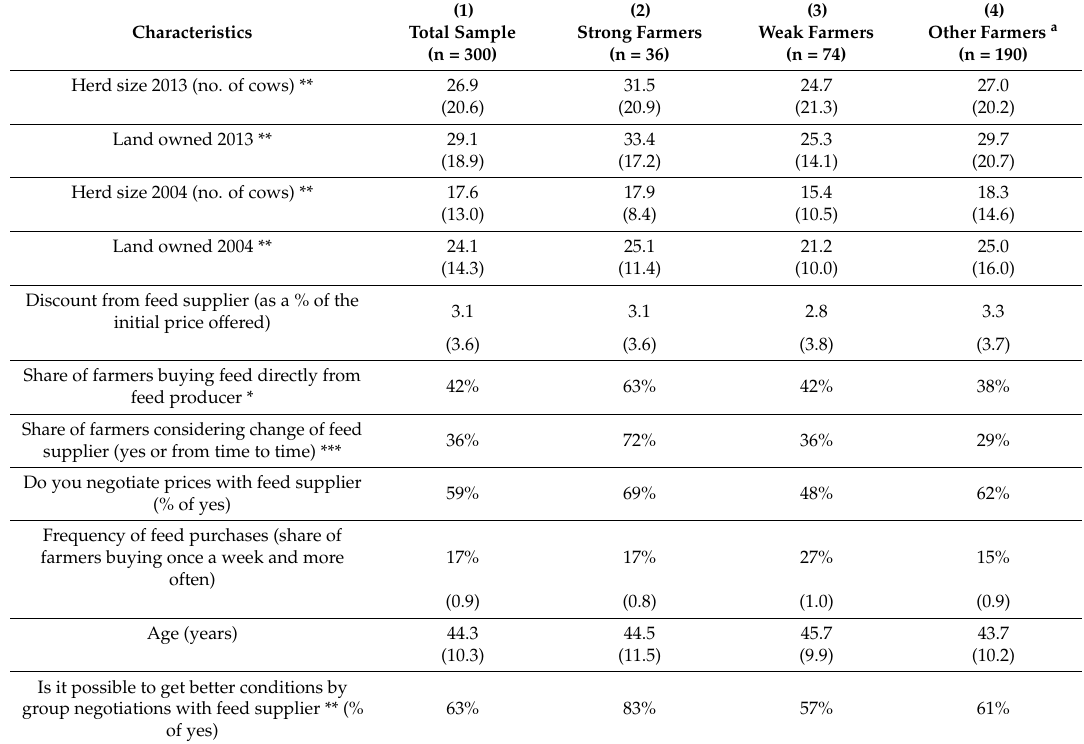
Table 1. Selected descriptive statistics for the variables used in the analysis (mean, standard